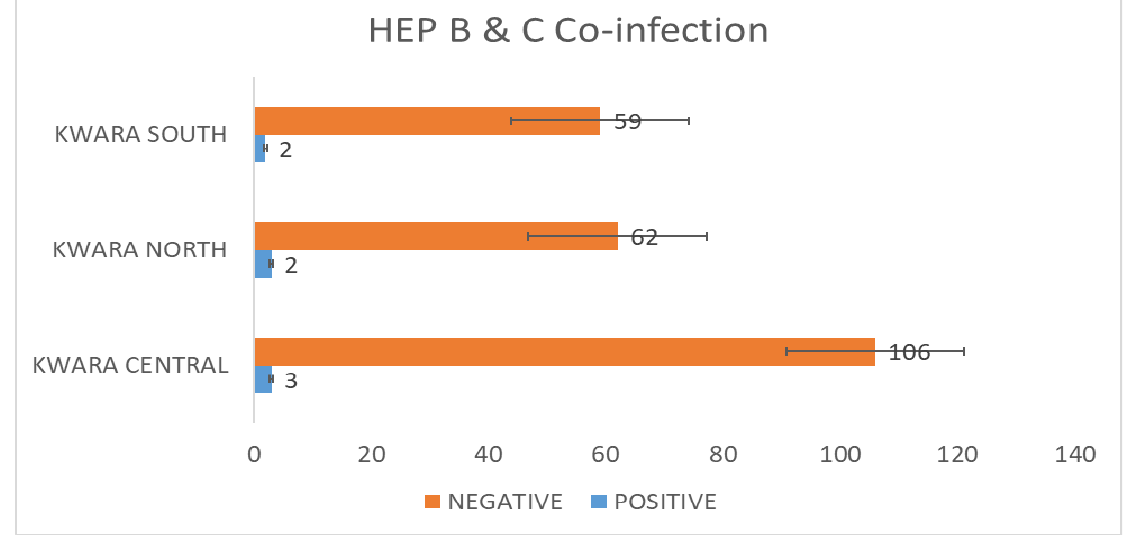
Figure 4. Co-infection of hepatitis B and C incidences among scavenger across the three senatorial